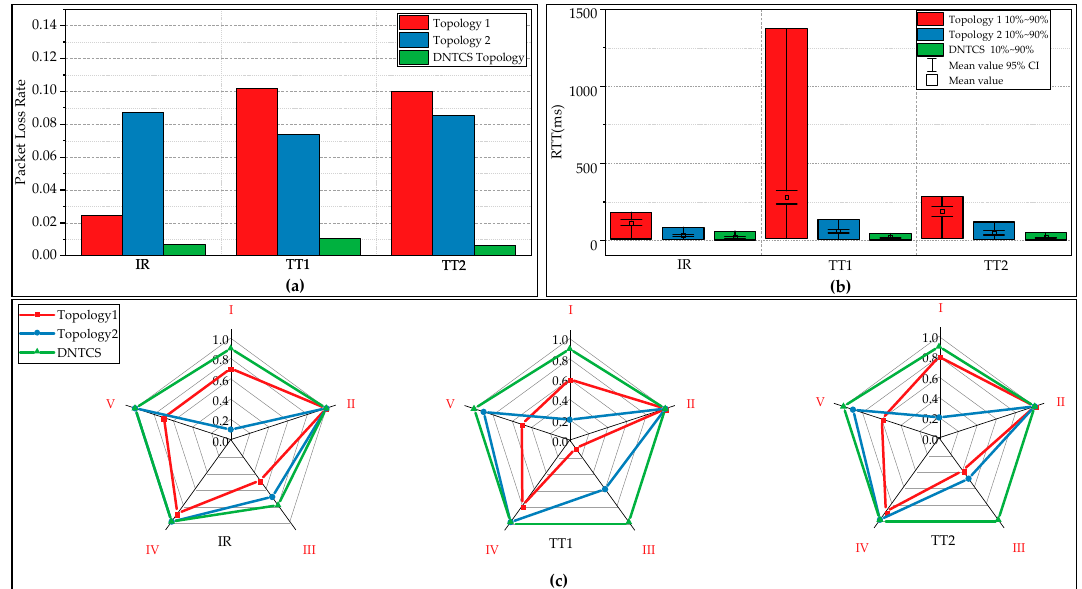
Figure 19. Results for Scenario 3.1 regarding the network performances of the mobile nodes. ( a ) Packet loss rate; ( b ) RTT; ( c ) normalized performance metrics.